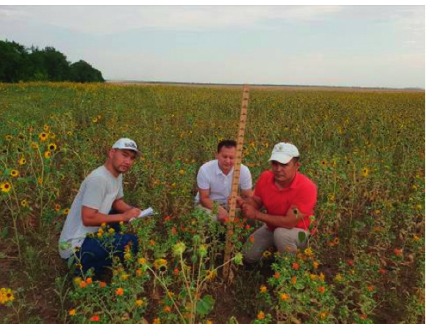
Figure 2: A scheme of the field